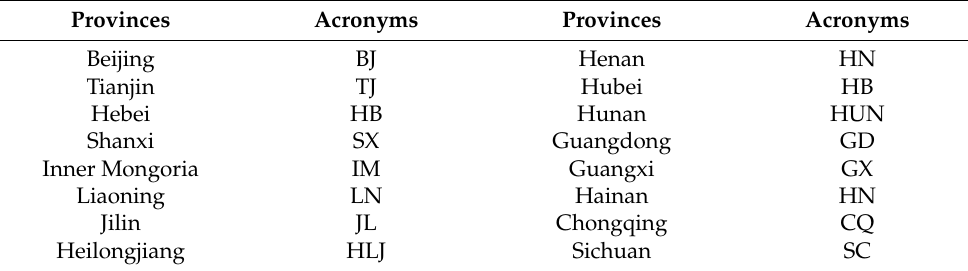
Table 7. The acronyms of 30 provinces in China.